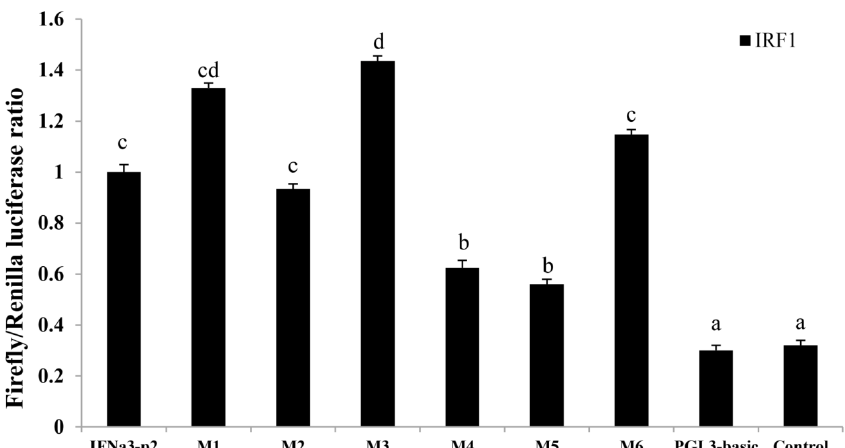
Figure 9. E ff ects of six mutants on ToIFNa3-p2 promoter activity. Mutations of promoter sequences are Figure 9. Effects of six mutants on ToIFNa3-p2 promoter activity. Mutations of promoter according to Reference [28]. Data are presented as the means ± SD ( n = 3). Di ff erent letters indicate sequences are according to Reference [28]. Data are presented as the means ± SD ( n = 3). Different letters indicate significant differences ( p < 0.05). significant di ff erences ( p < 0.05). Table 1. Primers used for sequence cloning, deletion mutant construction, mRNA construction, and qRT-PCR